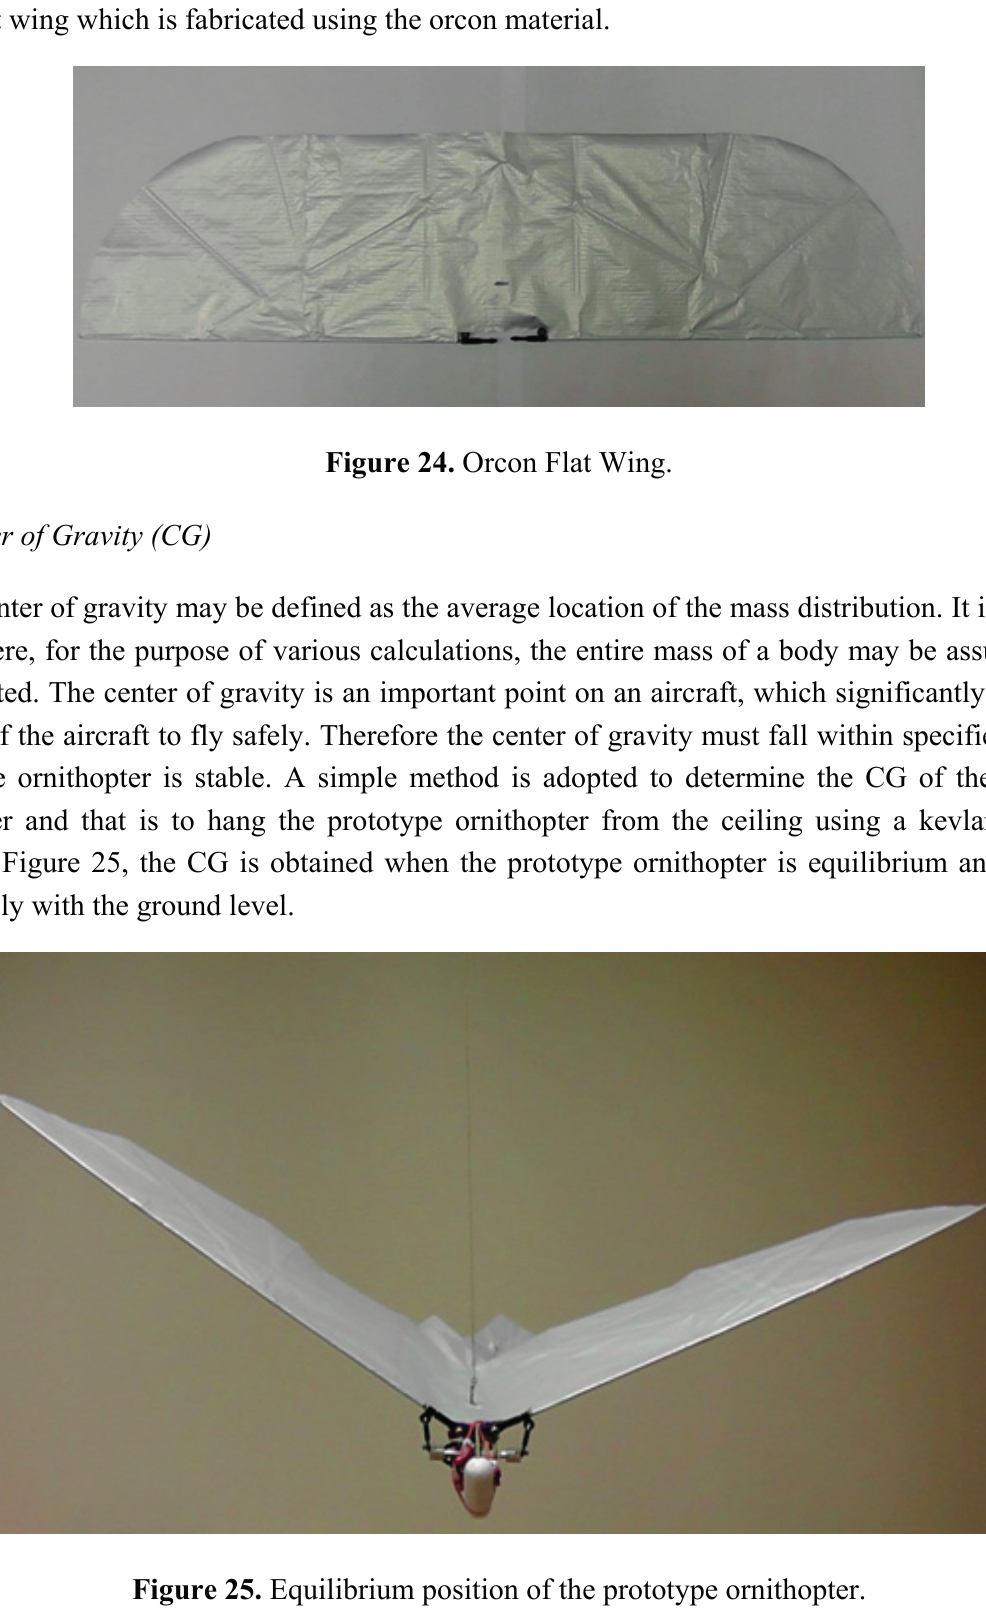
Figure 25. Equilibrium position of the prototype